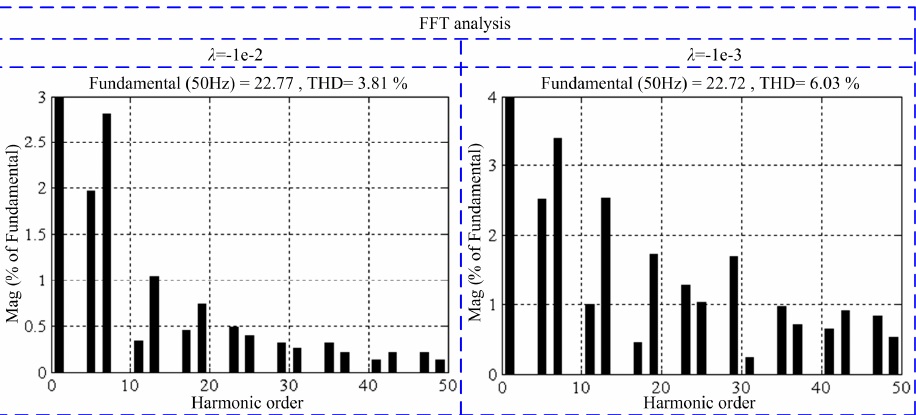
Figure 12. The FFT analysis of phase A grid current in steady-state condition. Table 2. Detailed simulation data.